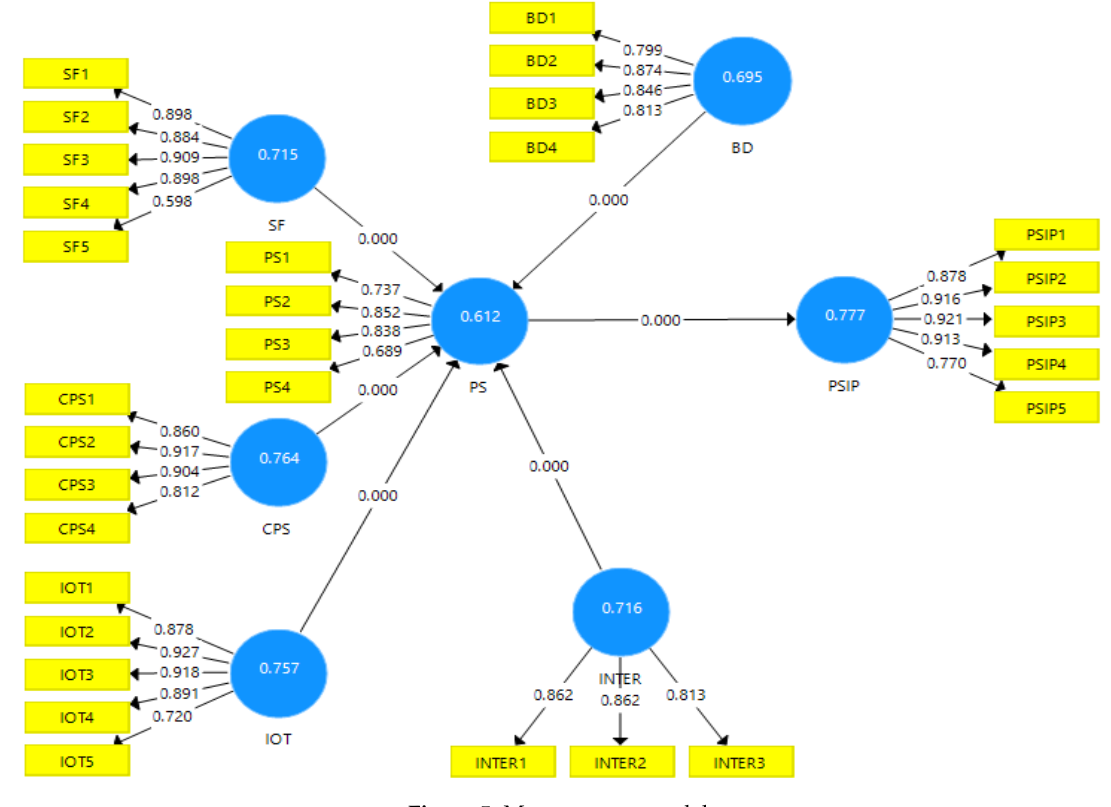
Figure 5. Measurement model.